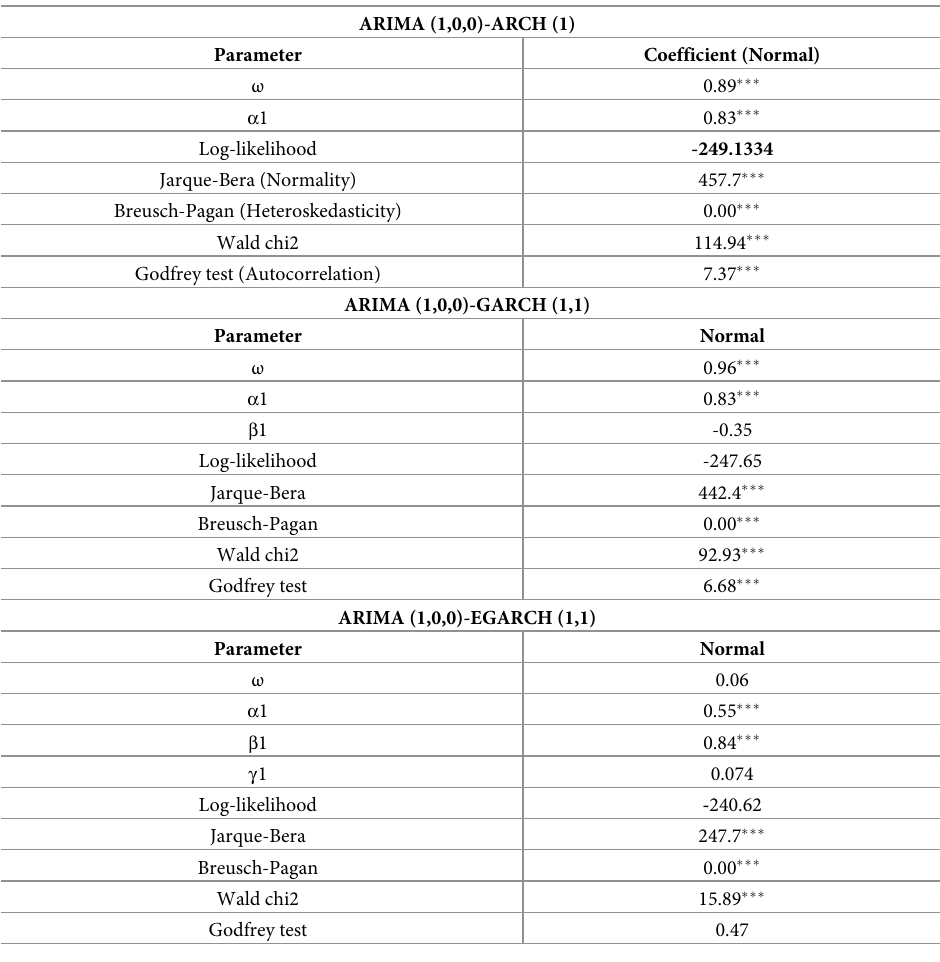
Table 6. Estimated ARIMA-GARCH family